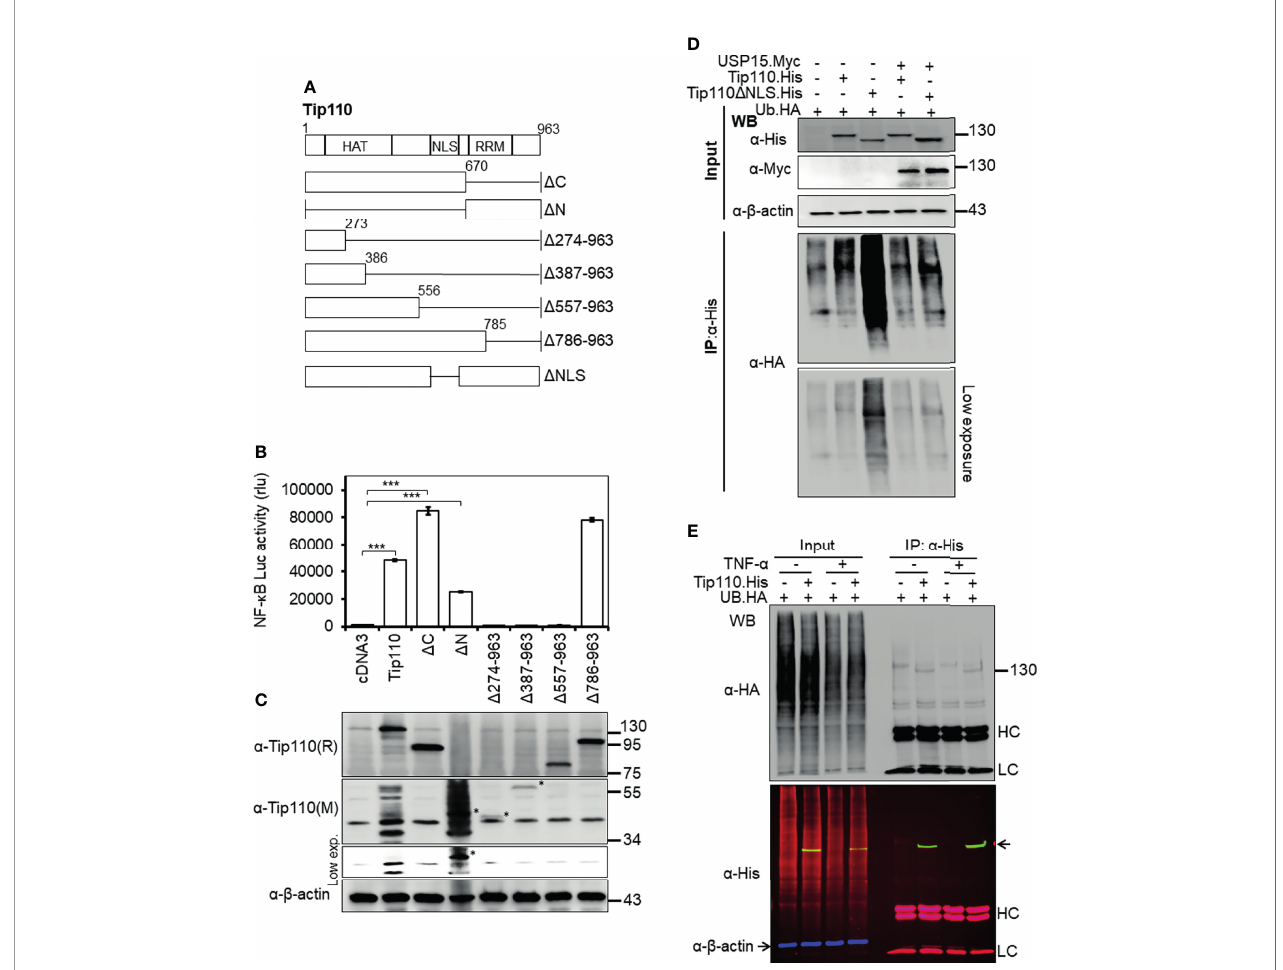
FIGURE 2 | Effects of Tip110 intracellular localization and ubiquitination on NF- k B activity. (A) Schematic of Tip110 and its respective deletion mutants. Tip110 consists of seven half-a-tetratricopeptide repeats (HAT), a nuclear localization signal (NLS), and two RNA recognition motifs (RRM). (B, C) 293T were transfected with 0.6 µg pGL3-NF- k B(3)-Luc and Tip110.His or one of the Tip110 deletion mutants. Cells were harvested 48 hr post-transfection for the luciferase reporter gene assay (B) and Western blotting for Tip110 and its mutant expression using a monoclonal (M) and polyclonal (R) anti-Tip110 antibody (C) . (D) 293T were transfected